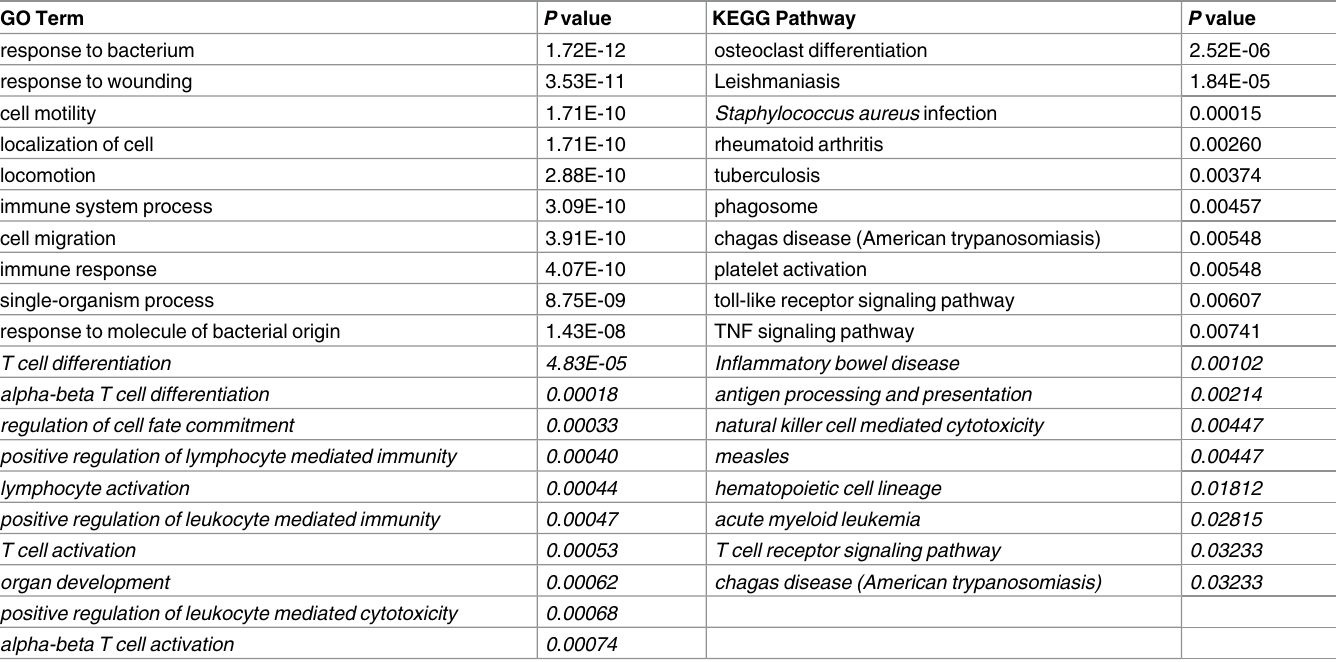
Table 1. GO and pathway analysis of upregulated mRNAsand downregulated